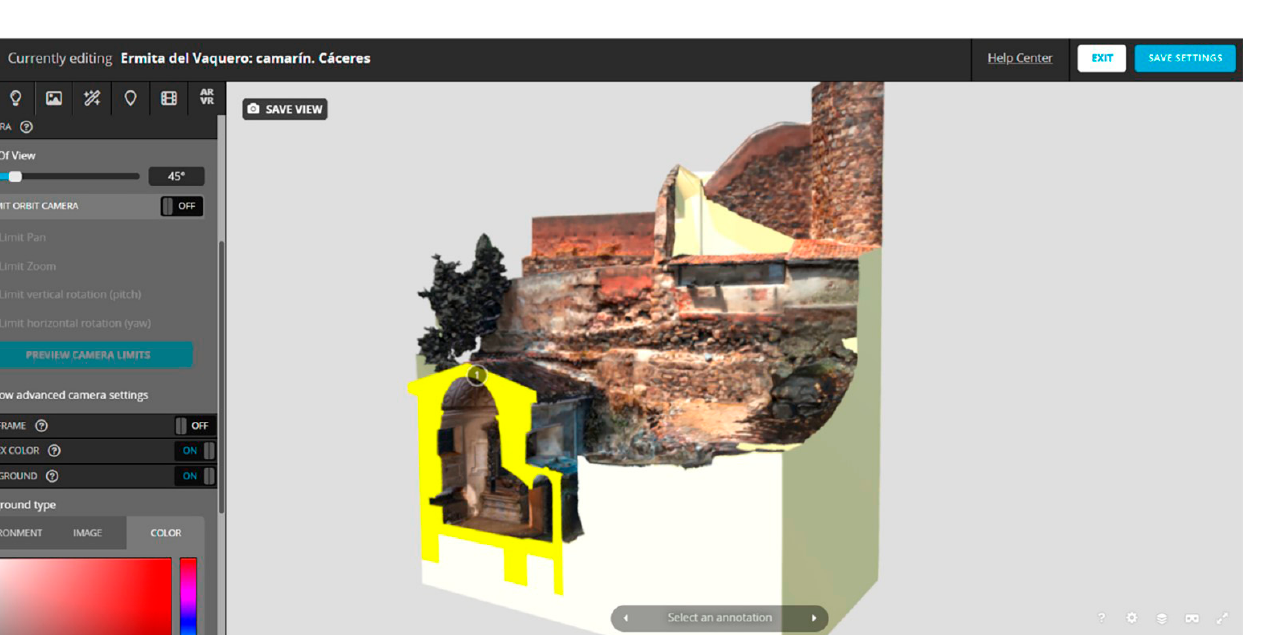
Table 7. Lighting modifier